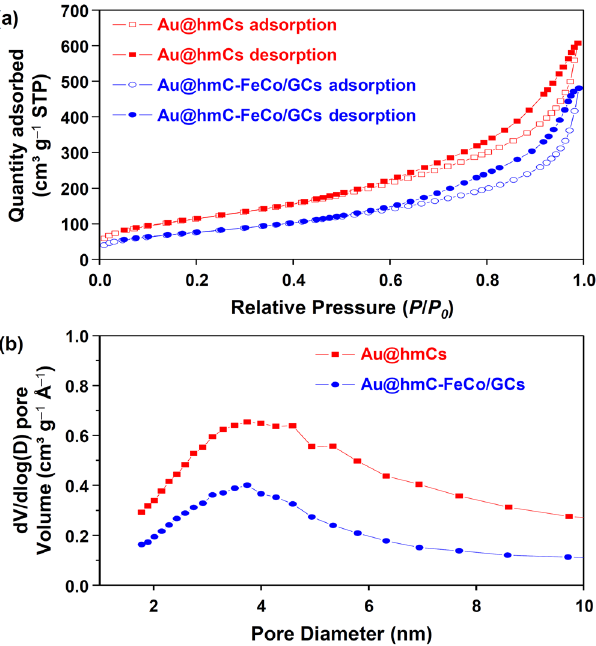
Figure 5. ( a ) Nitrogen sorption isotherms and ( b ) Pore size distributions of Au@hmCs and Au@hmC-FeCo/